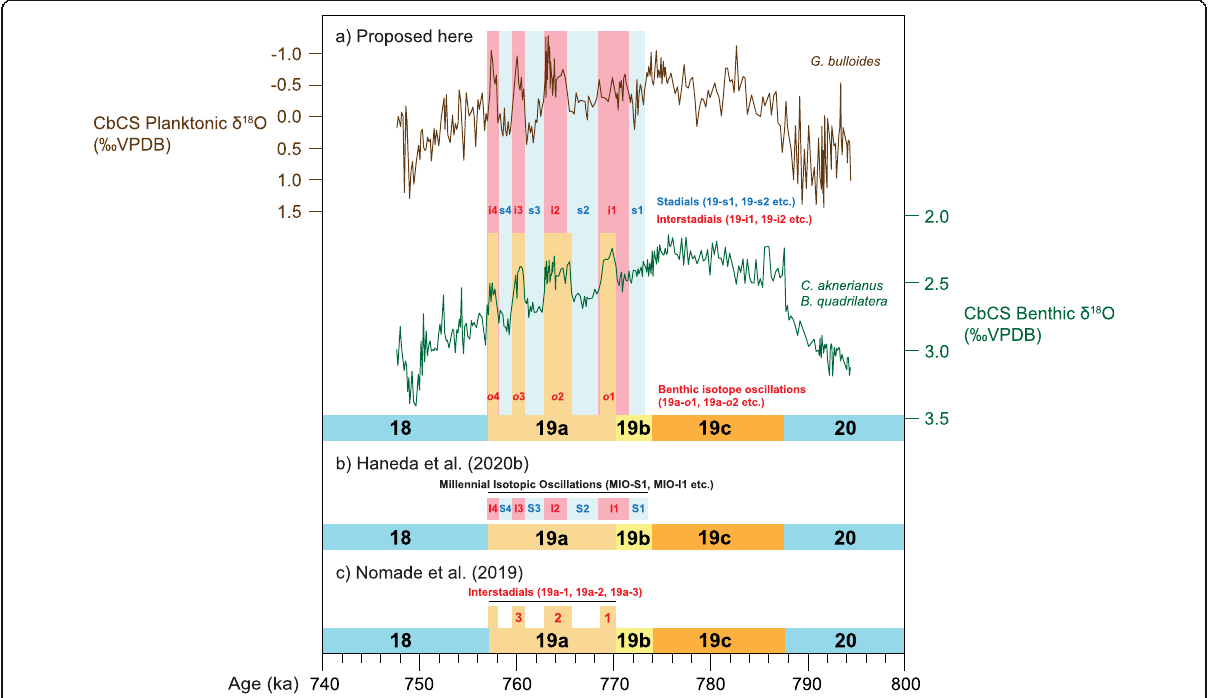
Fig. 7 Differing subdivisions of the interval comprising Marine Isotope Substages 19b and 19a illustrated using the isotope record of the Chiba composite section (CbCS; Haneda et al. 2020b). ( a ) Four millennial-scale benthic isotope oscillations (MIS 19a- o 1 to MIS 19a- o 4) represented in the benthic foraminiferal record by lighter values exclusively within MIS 19a. Four stadials (MIS 19-s1 to MIS 19-s4) and four interstadials (MIS 19-i1 to MIS 19-i4) reflect more localized millennial-scale paleoenvironmental alternations across MIS 19b – a, in this case characterized by the planktonic foraminiferal record. ( b ) The labelling scheme of Haneda et al. (2020b) based on the planktonic foraminiferal record of the CbCS. ( c ) The labelling scheme of Nomade et al. (2019) based on the benthic foraminiferal record of Montalbano Jonico,